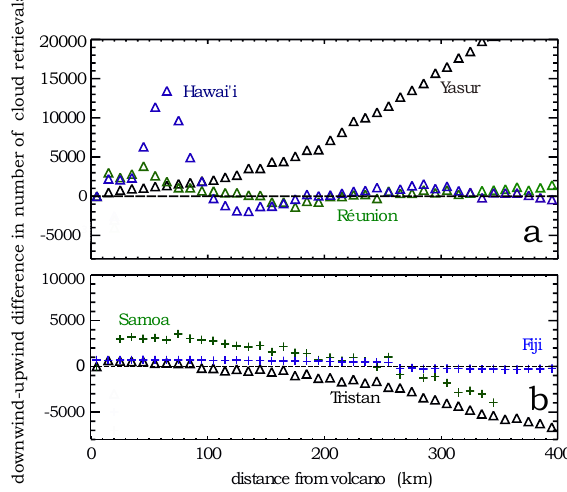
Fig. 6. Comparison of SO 2 flux from East Rift as reported by Elias and Sutton (2012), with AOD (550 nm) measurements from MODIS Aqua on the same day. The lack of relationship between ground and satellite-based measurements may be due to several factors including dilution effects and differences in measurement times. Black triangles show MODIS AOD retrievals and the black dashed line indicates linear regression line. The red crosses show AOD values after de-trending for a linear relationship with wind- speed, as demonstrated in Figure 11. The red dashed line shows corrected linear regression.